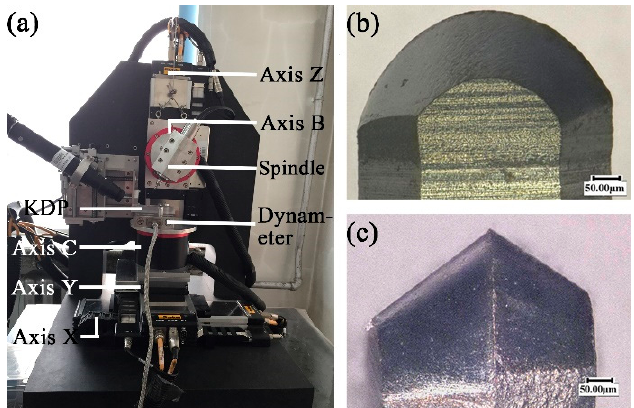
Figure 1. The machine tool system: ( a ) main components; ( b , c ) side views of polycrystalline diamond (PCD) micro ball end mill.